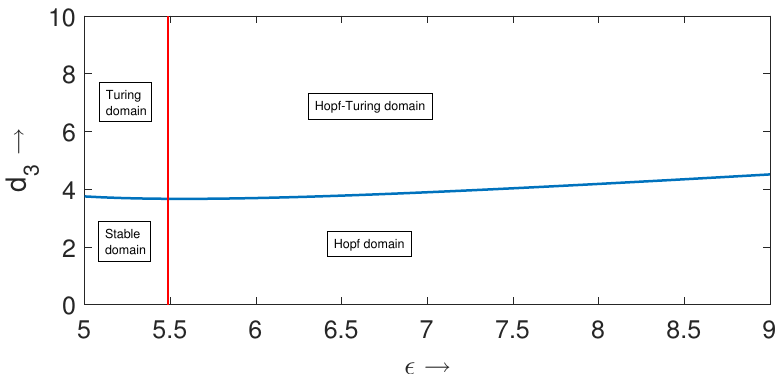
Figure 2. Plots of temporal-Hopf and Turing bifurcation curves in ( (cid:101) , d 3 ) -parameter space for the local spatiotemporal model (11)–(13). Here, red vertical straight line represents the temporal-Hopf bifurcation threshold and the blue curve represents the Turing bifurcation curve. Other parameter values are mentioned in (25). The red vertical straight line has been drawn by solving the equations presented in (9) simultaneously and the blue curve has been drawn from the Equation